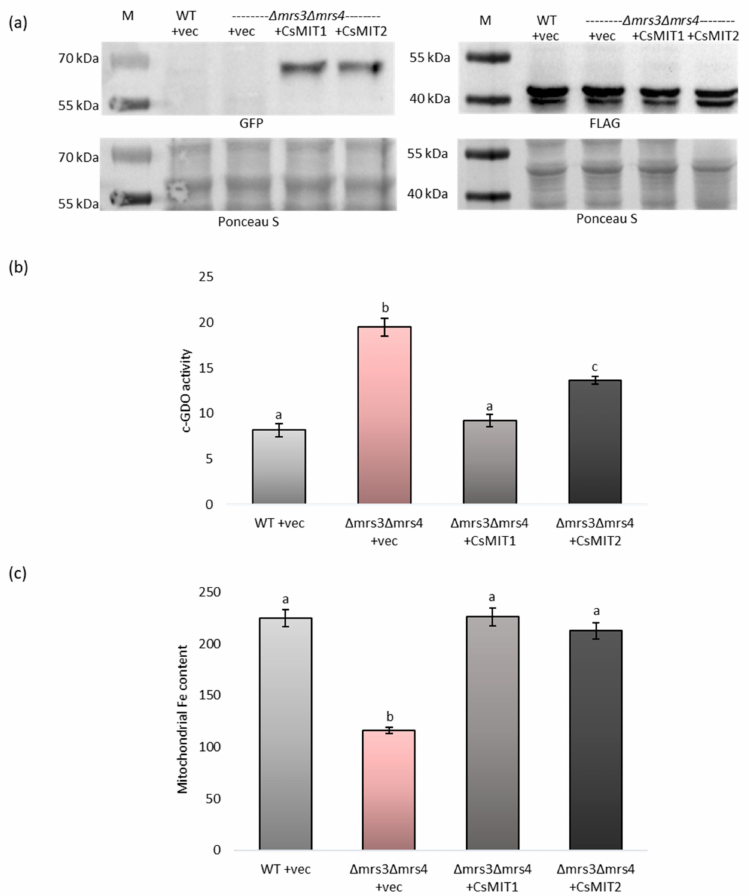
Figure 5. Cytosolic and mitochondrial Fe content in yeast expressing CsMIT1 and CsMIT2. ( a ) Western blot analysis of CsMIT1-GFP and CsMIT2-GFP (left) or c-GDO-FLAG (right) proteins in yeast ∆ mrs3 ∆ mrs4 transformants using the antibodies against GFP and FLAG, respectively. ( b ) c-GDO activity in WT and ∆ mrs3 ∆ mrs4 cells expressing c-GDO-FLAG and either empty vector, CsMIT1-GFP or CsMIT2-GFP. c-GDO activity is expressed as nanomoles of substrate converted per minute per mg of protein. Results shown are the means of four biological replicates; error bars represent standard error (+/-SE). Different letters represent statistically significant differences ( p < 0.05; ANOVA with Tukey’s correction). ( c ) Mitochondrial Fe content in WT and ∆ mrs3 ∆ mrs4 cells expressing either empty vector, CsMIT1-GFP or CsMIT2-GFP. Results as shown are expressed as the mean Fe level of three biological replicates (nmol mg-1 protein); error bars represent standard error (+/-SE). Different letters represent statistically significant differences ( p < 0.05; ANOVA with Tukey’s